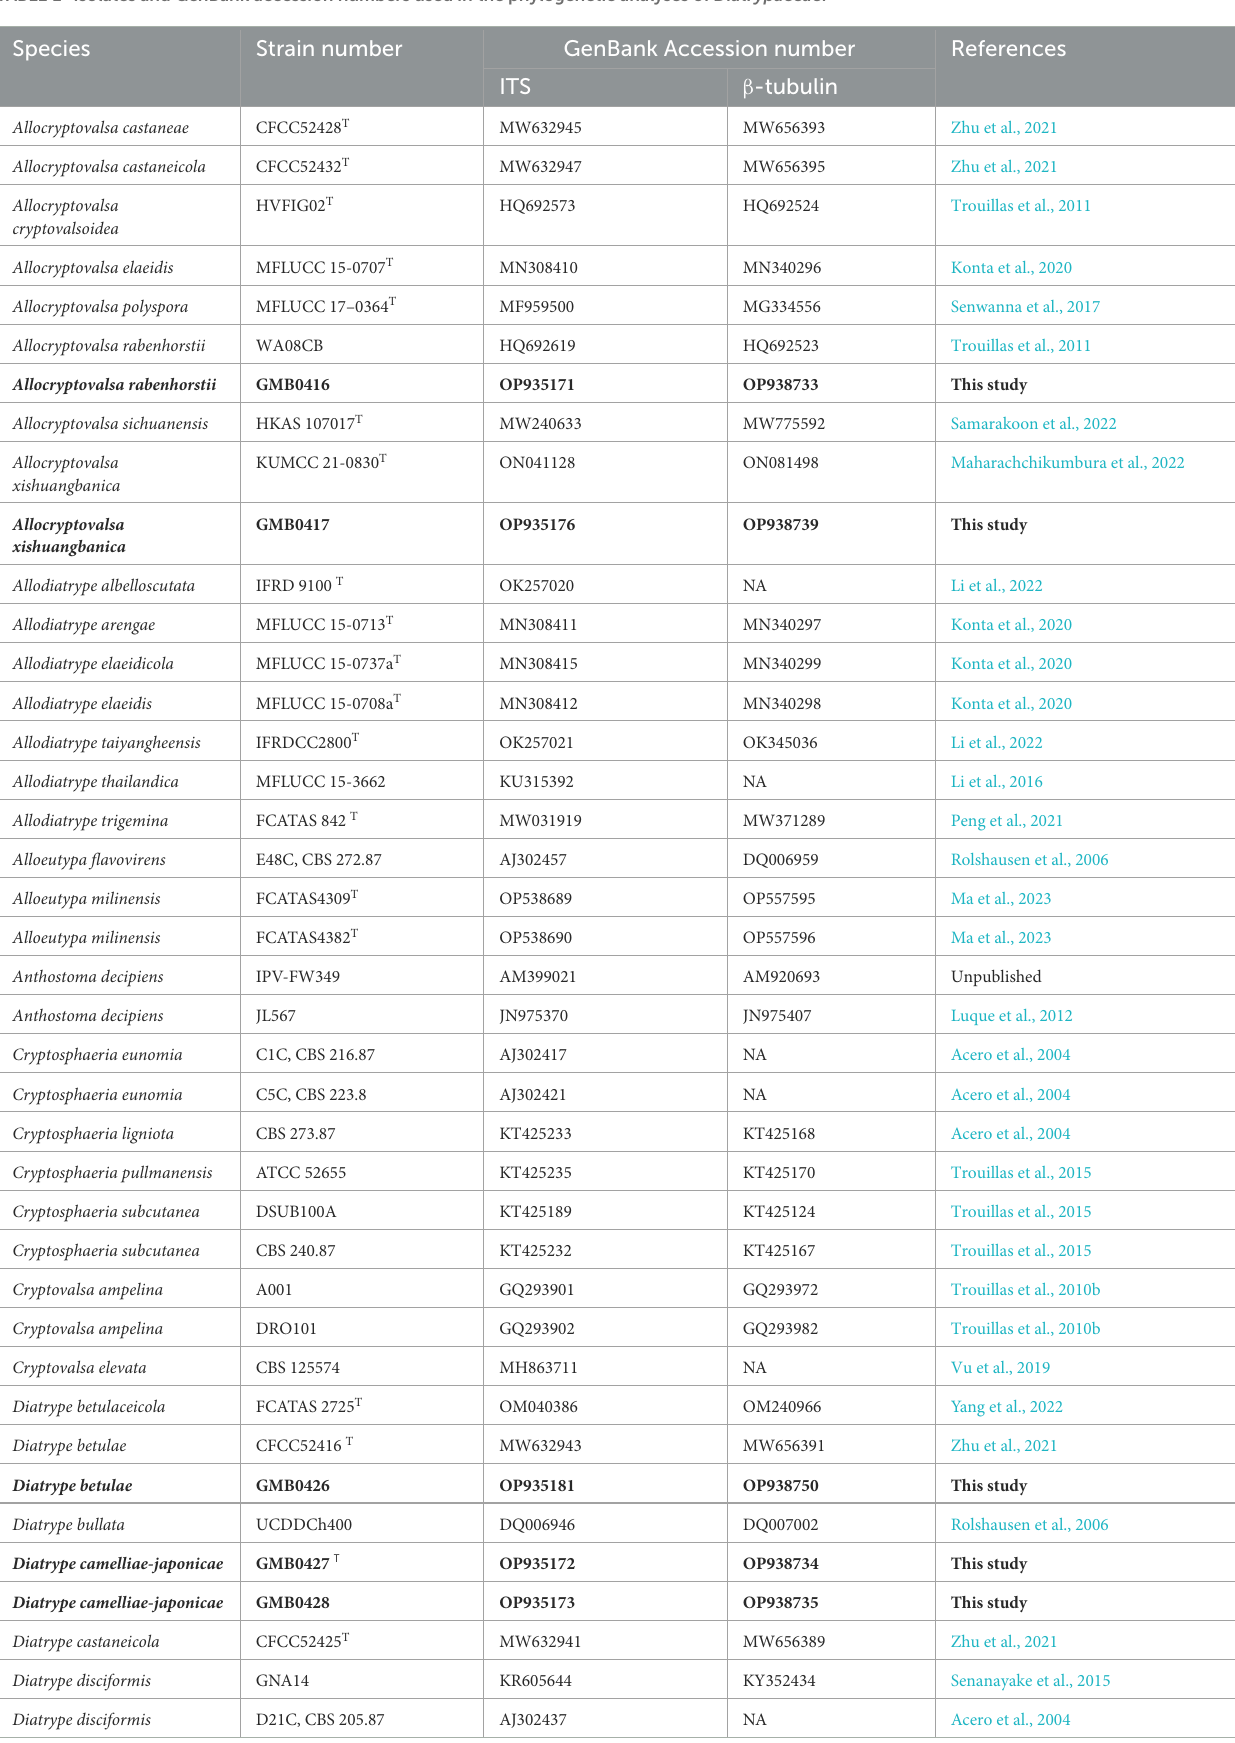
TABLE 1 Isolates and GenBank accession numbers used in the phylogenetic analyses of Diatrypaceae